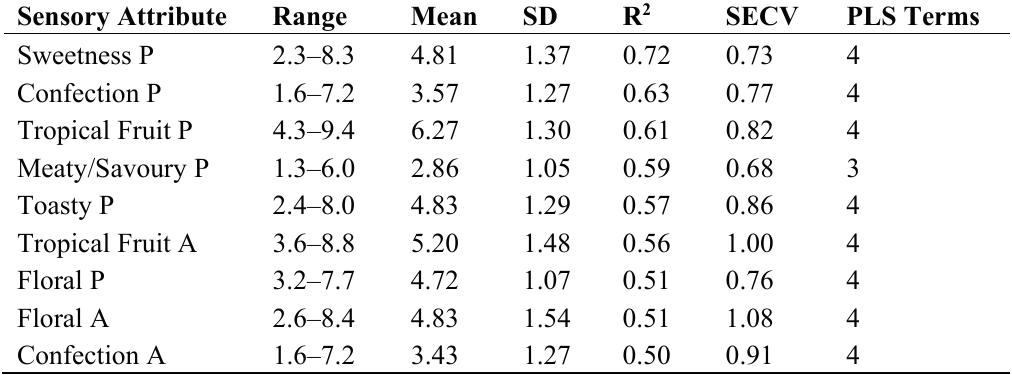
Table 2. Range, mean, standard deviation (SD) and cross validation statistics for sensory attributes in sparkling white wine samples analyzed by ATR-MIR spectroscopy. Sensory Attribute